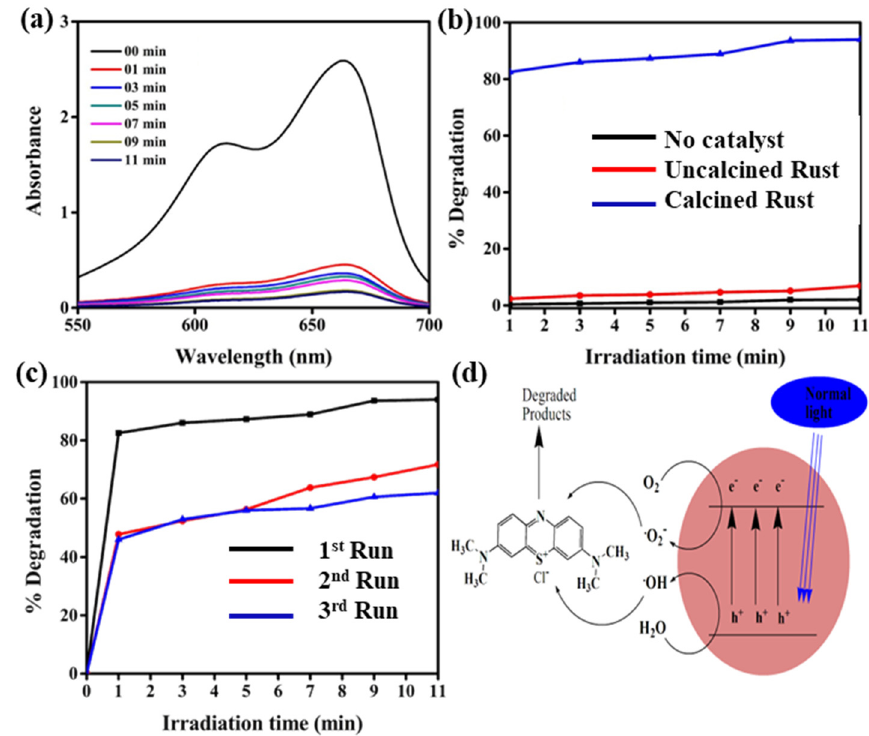
Figure 4. ( a ) UV–Vis spectra of MB photodegraded by calcined rust NPs in aqueous medium under visible light; ( b ) %degradation comparison of MB dye photodegraded by uncalcined rust, calcined rust NPs, and without photocatalysts; and ( c ) reusability of calcined rust NPs. ( d ) Proposed mechanism for the photodegradation of MB, adopted from [59]. Table 1: Comparison of the photodegradation of MB dye by our photocatalysts and Fe 2 O 3 -based 312 photocatalysts in the literature. 313